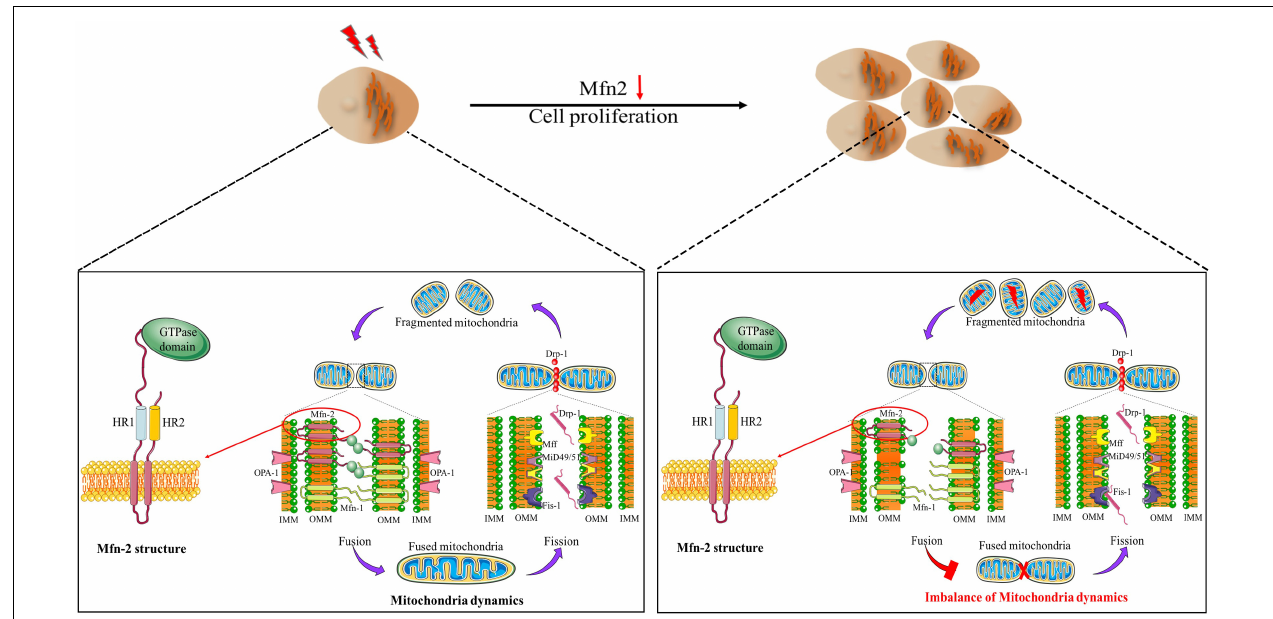
FIGURE 1 | Mitochondria dynamics and Mfn-2 structure. Mfn-2 is one of the main factors regulating mitochondrial fusion. The N-terminal of Mfn-2 is the GTPase domain. There are two HR domains and two transmembrane